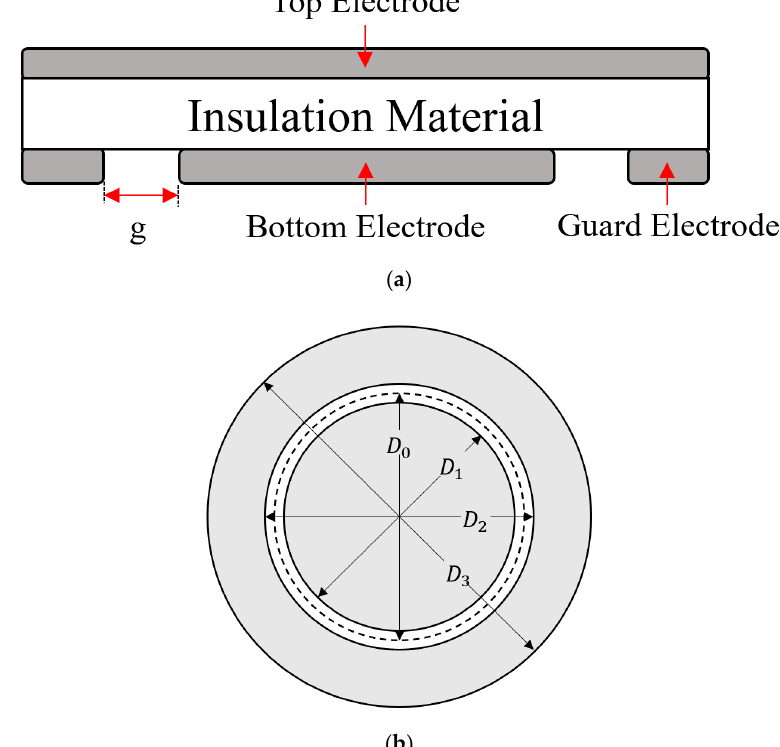
Figure 1. Specimen for measuring the volume and surface resistance: ( a ) electrode structure; ( b ) flat specimen electrode.